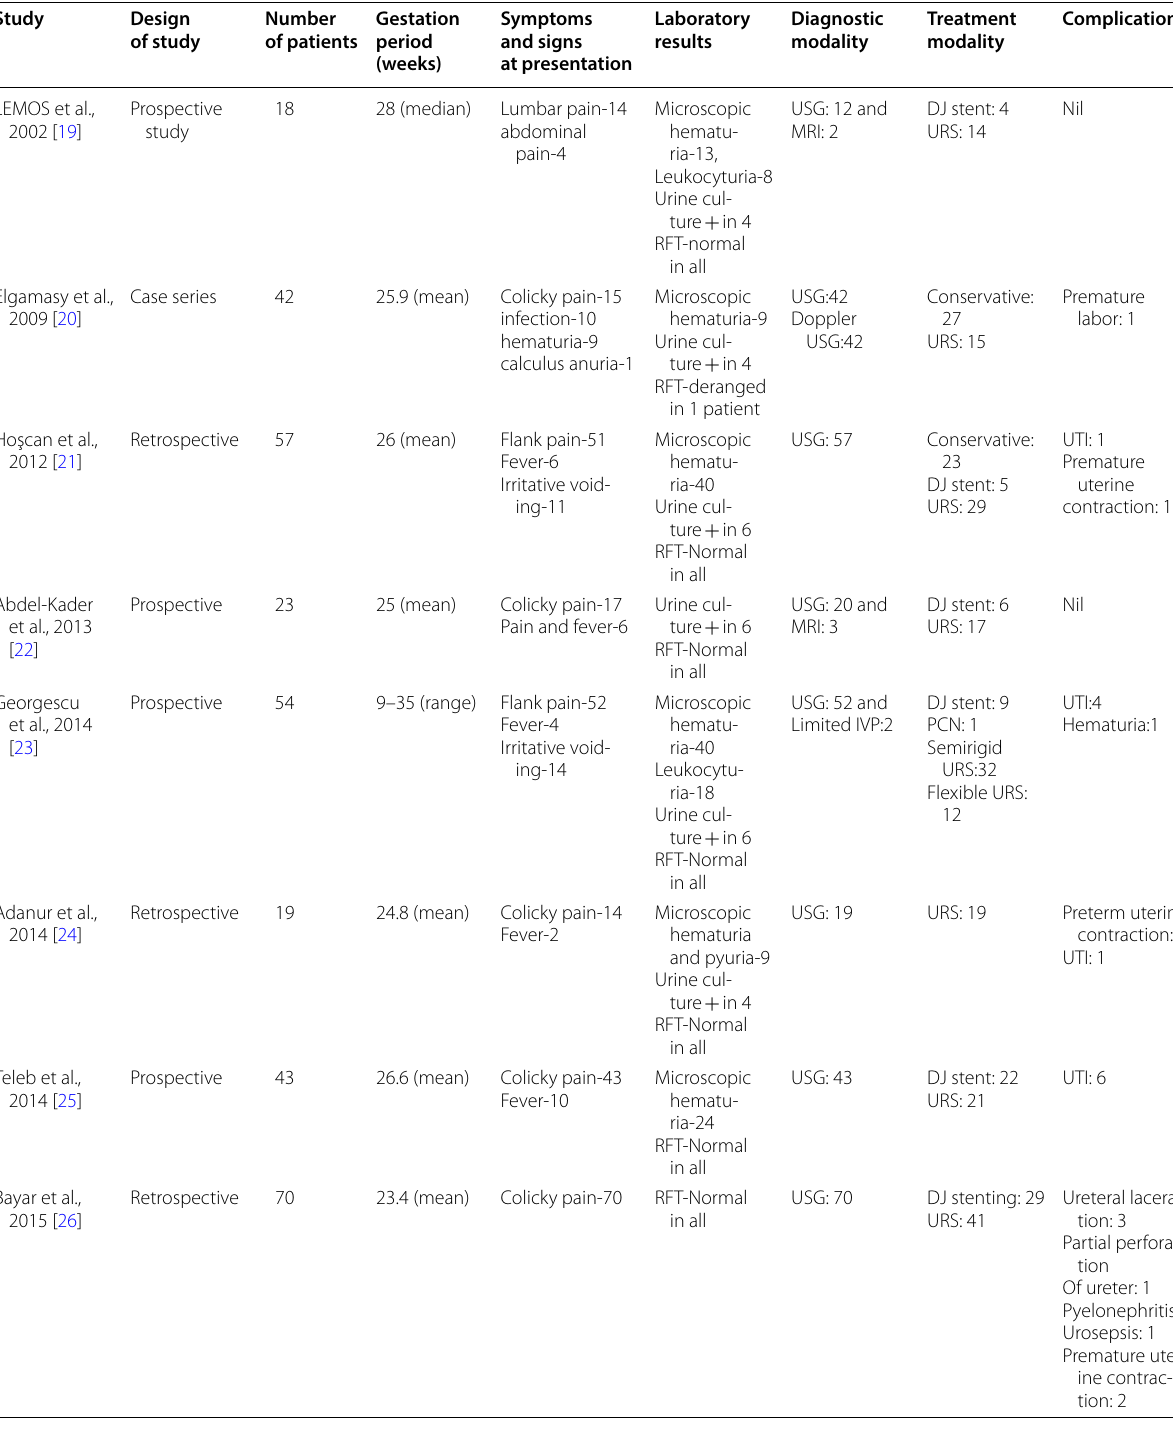
Table 1 Nine studies reporting management of ureteric stone in pregnancy were reviewed Study Design of